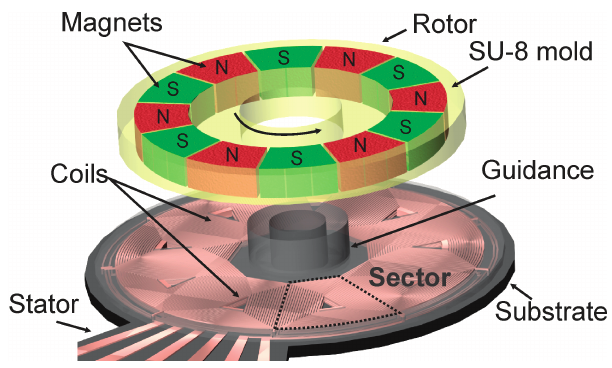
Figure 5. Concept of rotatory synchronous micromotor. Reprinted with permission from [30], Copyright 2008 International Frequency Sensor